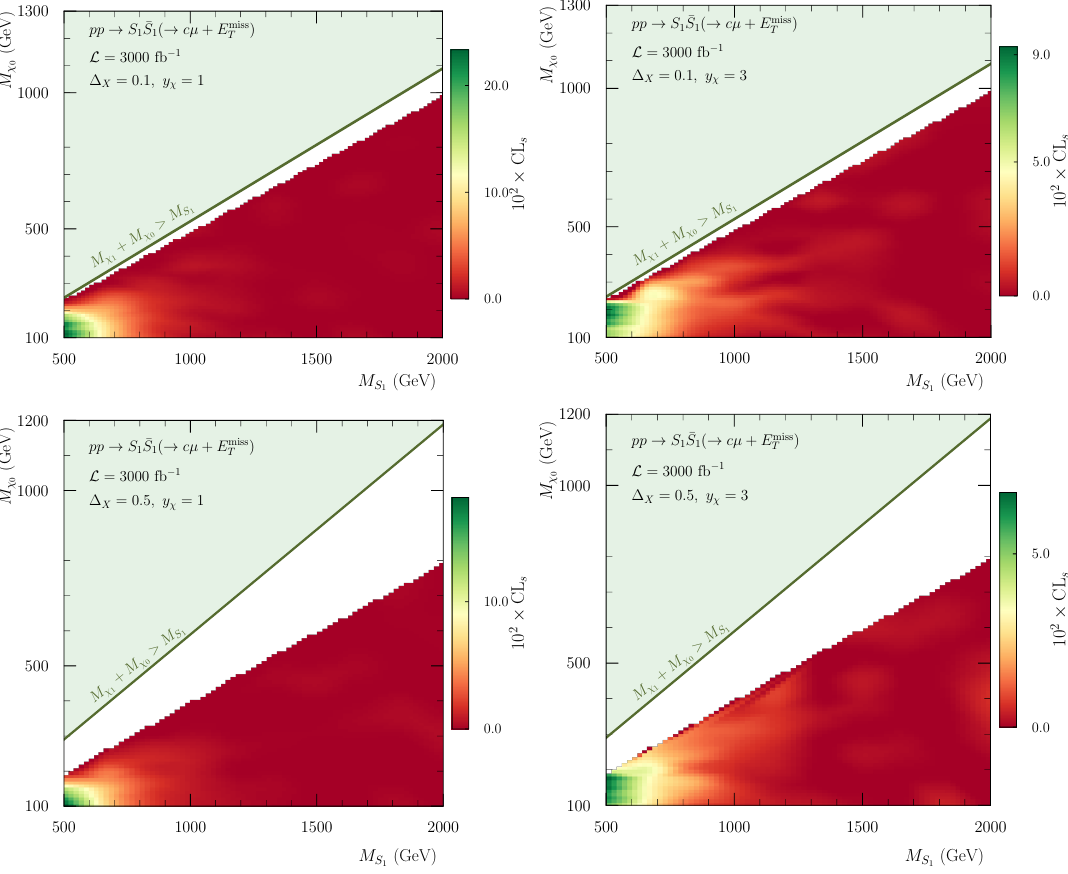
Figure 23 . Same as figure 10 but for a luminosity L = 3000 fb − 1